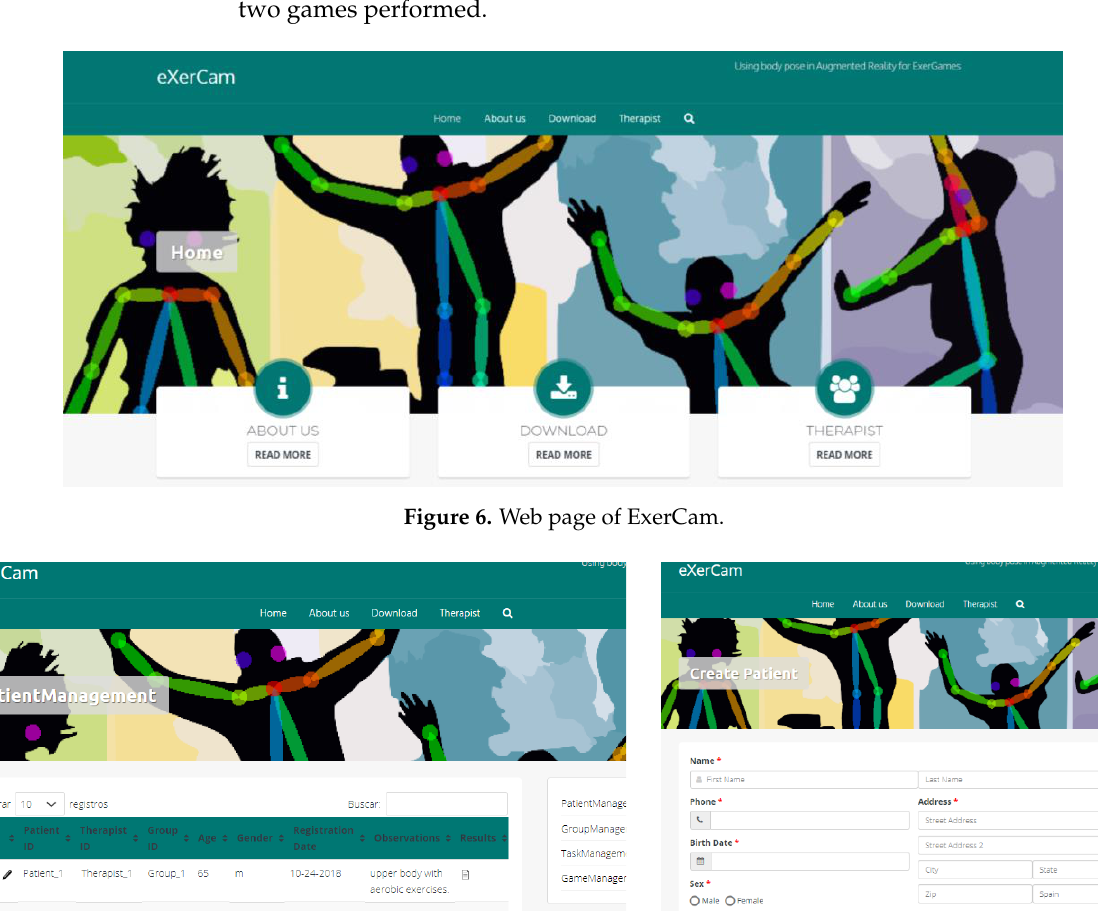
( d ) Game 4: Bars Figure 5. Different types of exergames developed.